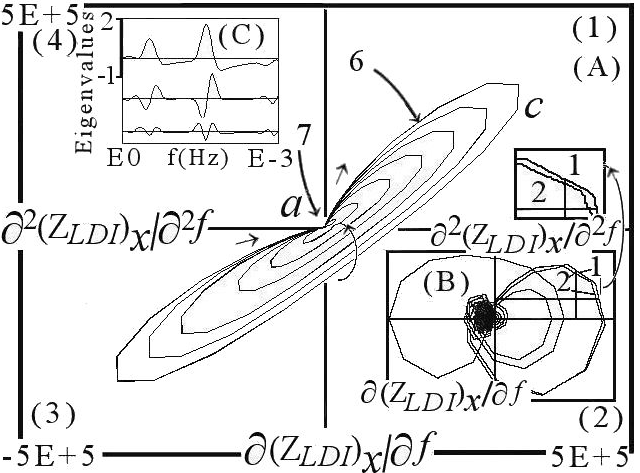
Figure 12. ( A ): Phase-space derivative at low frequency in converging spirals (event 6) for region of voltammetry peak A; ( B ) example of a graph to select vectors (Figure 11 event 5) for determination of Lyapunov exponent in the upper right quarter, same scaling; ( C ) eigenvalues at low-frequency